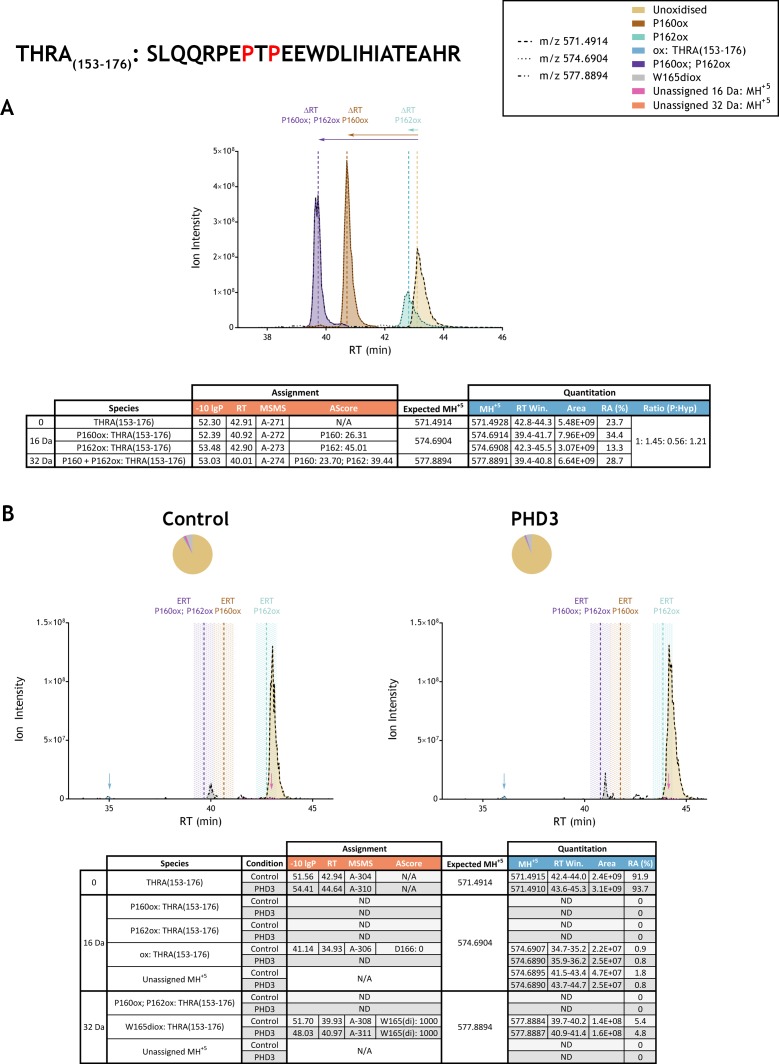
Quantitation of peptide oxidation on THRA(153-176) following reaction of full-length thyroid hormone receptor alpha with recombinant PHD3.XIC data presented in (A) shows ion intensity and retention time (RT) characteristics of equimolar synthetic peptide standards for unoxidised and proline oxidised forms (P160ox, P162ox or combined) of the THRA(153-176) peptide. MSMS assigned species are coloured (see inset); vertical dashed lines define peak maxima used to derive ΔRT values for the different hydroxyproline-containing peptides. Panel (B) shows comparable XIC data for protease-digested IVTT substrate under control (left) or PHD3-reacted (right) conditions. Peaks corresponding to unoxidised (light brown) and low stoichiometry singly-oxidised (blue arrow) and doubly-oxidised (grey) forms of THRA(153-176) were detected in control and PHD3-reacted IVTT preparations. The site of oxidation was ambiguous in the context of the singly-oxidised peptide (nominally localised to D166: AScore 0; see Supplementary file 1 A-306) and assigned as tryptophan di-oxidation (W165: AScore 1000; see Supplementary file 1 A-308 and A-311 for MSMS) on the doubly-oxidised peptide. The elution profile of the low abundance singly oxidised ions was chromatographically distinct (>5 min) from the expected retention time (ERT) of hydroxyproline-containing peptides (indicated by dashed vertical lines; shading corresponds to a 1 min RT window) and did not change in abundance relative to the unoxidised peptide following reaction with PHD3. Peptide ions of low abundance that were compatible with a single (+16 Da) oxidation event but not assigned by MSMS are indicated (pink arrow); unassigned ions with a compatible mass over charge for double oxidation (i.e.,+32 Da) were not observed across the elution window. Quantitative data for observed species are presented as pie charts with XIC data. Assignment and quantitation data are tabulated below each panel, table headers are as follows: (−10lgP) significance score of leading assignment at given (RT) with ambiguity score (AScore) for PTM localisation and reference to primary MSMS data in Supplementary file 1. Species column: Fragment ions (including neutral loss ions) localise mono-oxidation† to residues 165–166 (see Supplementary file 1, A-306). Quantitative data reports ion counts (Area) of observed masses (MH+5) integrated over time (RT Win.), expressed as relative abundance (RA). Data on detection efficiency for synthetic peptides (Panel A, P: Hyp) is an aggregated ratio of prolyl (P) to hydroxyprolyl (Hyp) containing species.